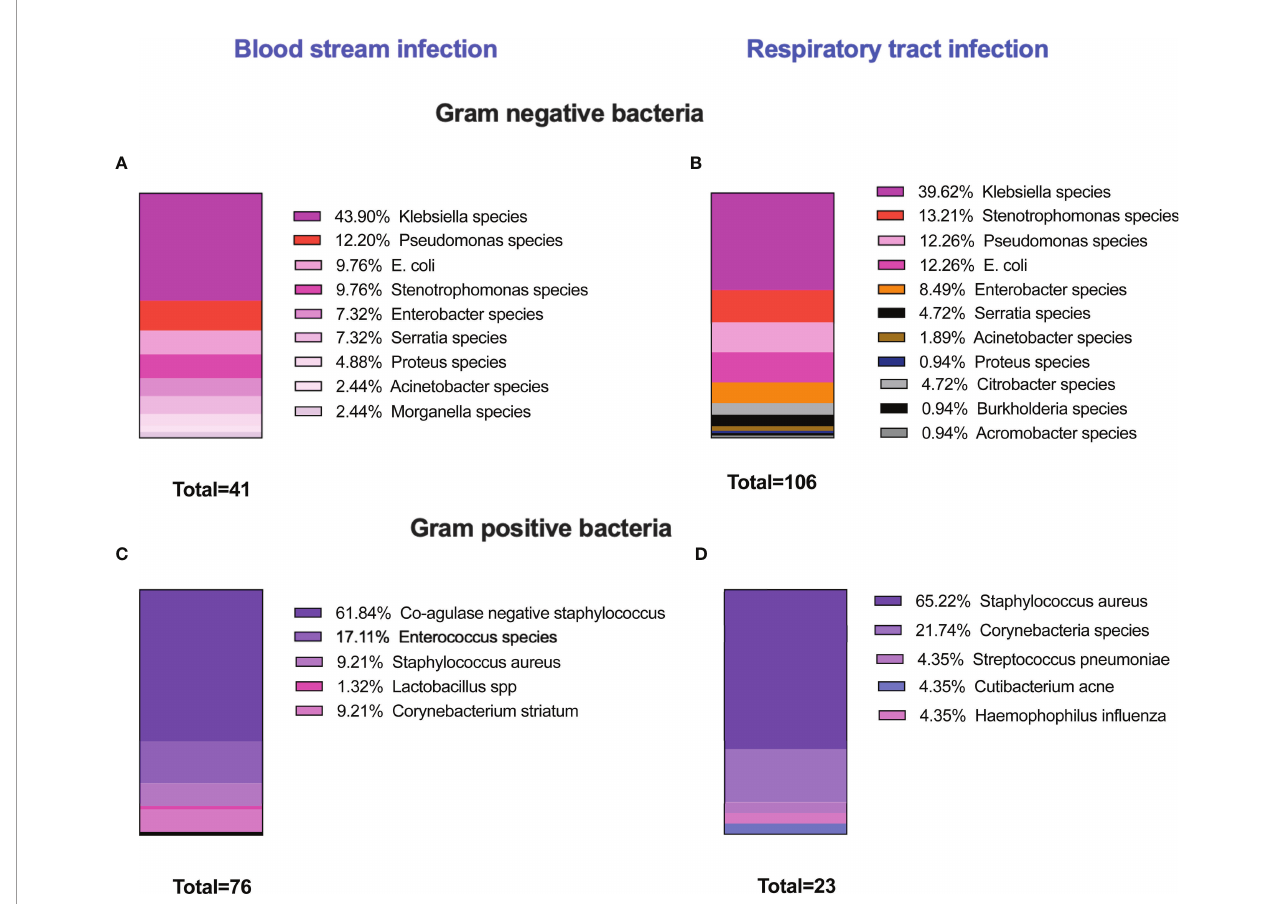
FIGURE 1 | Prevalence of secondary bacterial infection among severely ill COVID-19 patients. 217 patients were recruited in this study. 142 patients developed secondary bacterial infections. The microbiology analysis showed that different microbial species were isolated either from blood or respiratory cultures. The majority of infections were caused by Gram-negative bacteria, and Klebsiella species were the most common organism detected either in blood or respiratory cultures (A, B) . High incidences of Gram-positive bacteria were also identi fi ed and coagulase-negative staphylococcus species were the dominant Gram-positive bacteria in blood cultures, and S. aureus was the predominant organism in respiratory cultures (C, D) . In several occasions, multiple microorganisms were isolated from one